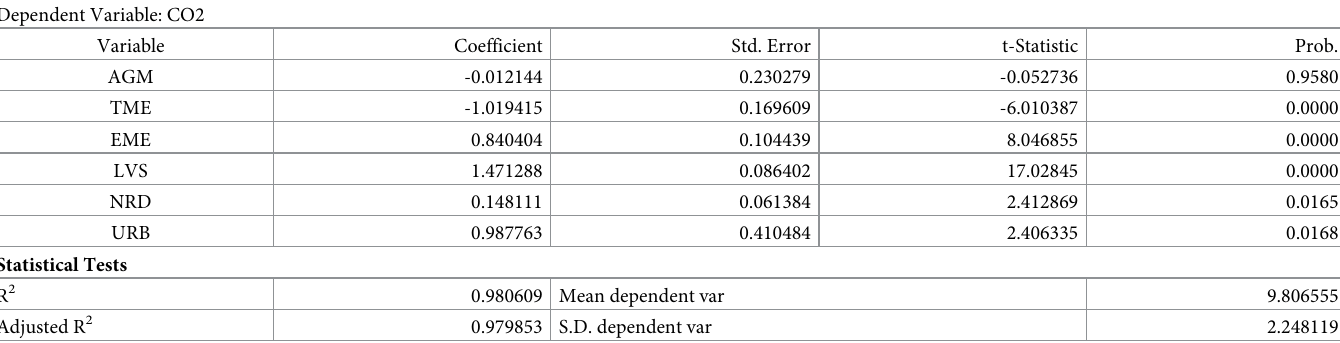
Table 8. Panel FMOLS